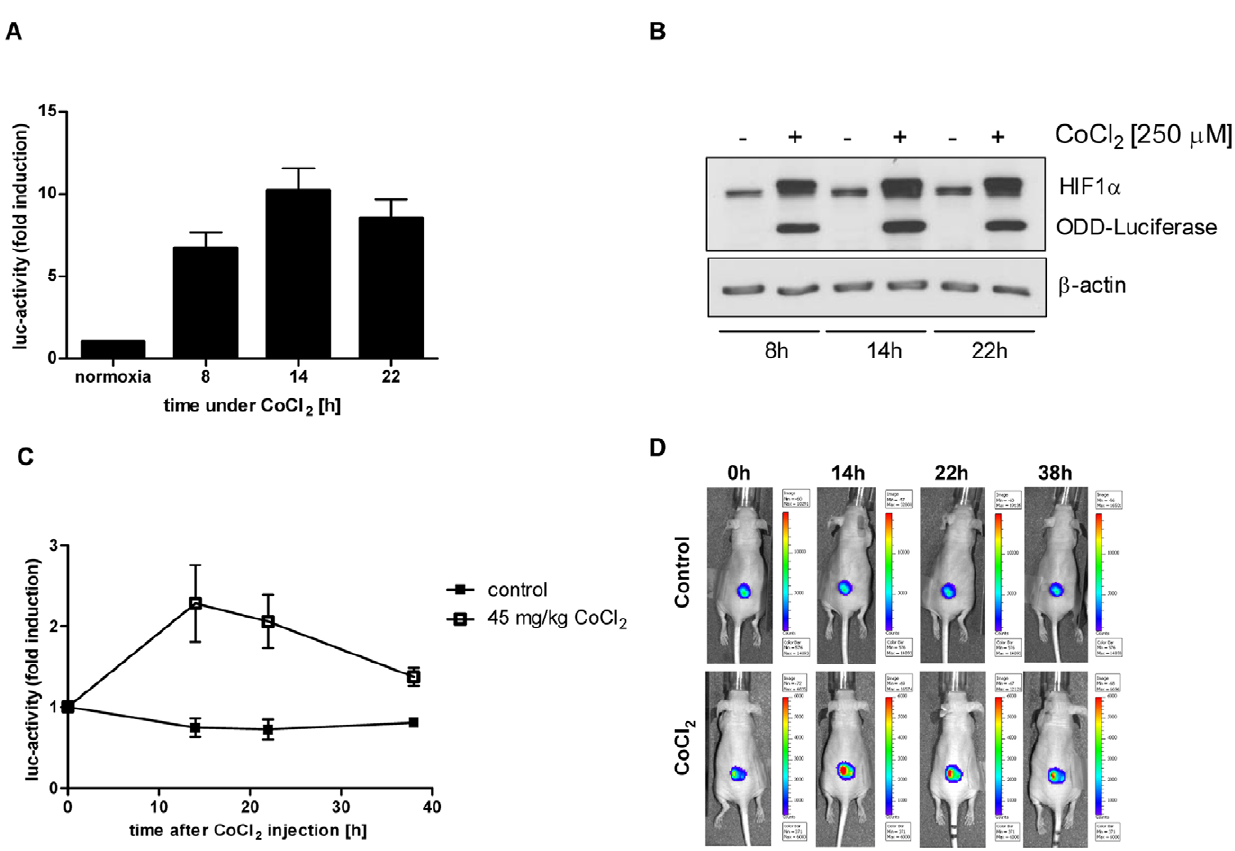
Figure 2. CoCl 2 increases luciferase activity in A549 ODD-Luc cells invitro and invivo . (A,B) Luciferase-activity (A) and HIF-1 a , and protein levels of ODD-luciferase (B) of CoCl 2 (0.25 mM)-treated, stably transfected ODD-Luc A549 cells, determined at the indicated time points. Error bars represent mean 6 SE. (C) Luciferase activity of A549 ODD-Luc-derived tumor xenografts in mice injected with CoCl 2 (45 mg/kg) at time point 0 hour and at the indicated time points thereafter. (n CoCl2 =6; n control =4) Error bars represent mean 6 SE. (D) Representative in vivo bioimages of untreated and CoCl 2 -treated mice.